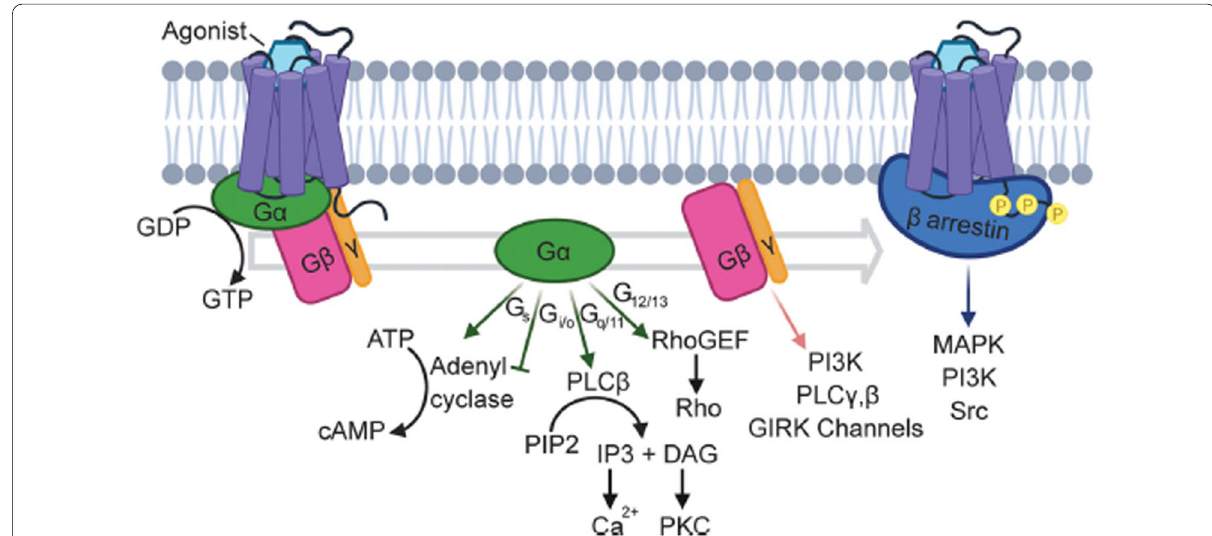
Fig. 4 Interaction of G protein-coupled receptors (GPCRs) with a variety of downstream endogenous partners using biased ligand signalling